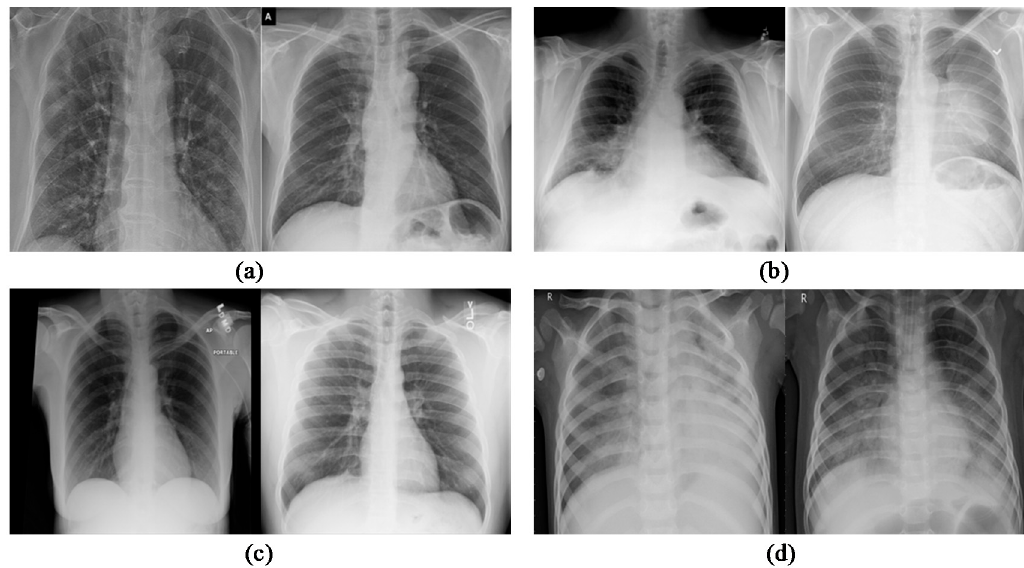
Figure 1. Pictorial representation of ( a ) COVID-19 images, ( b ) bacterial_pneumonia images, ( c ) normal images, ( d ) vi- ral_pneumonia images.